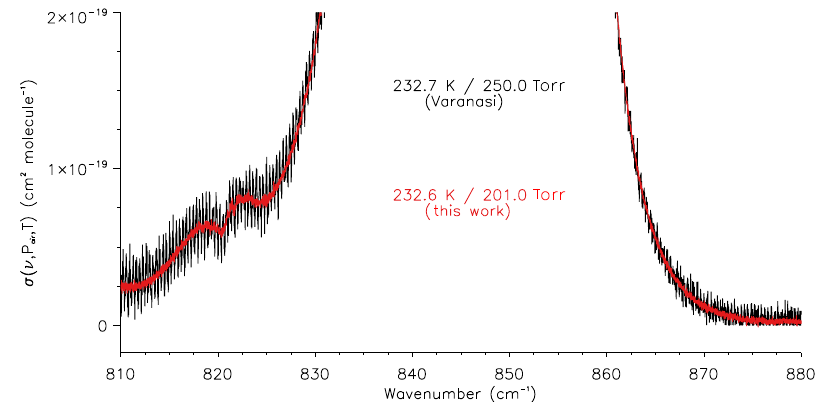
Figure 4. The Varanasi absorption cross section of trichlorofluoromethane/dry synthetic air at 232.7K and 250.0Torr (black), with the new cross section at 232.6K and 201.0Torr overlaid (red; this work). Channel fringes in the Varanasi cross section are clearly visible.